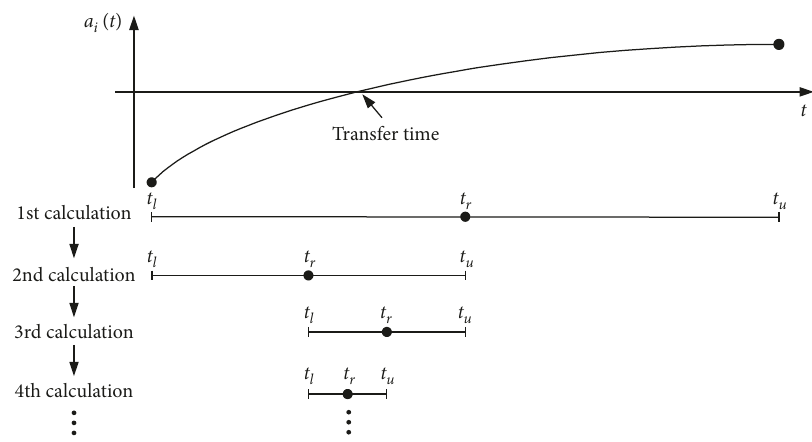
Figure 3: Zero-crossing detection using bisection method.